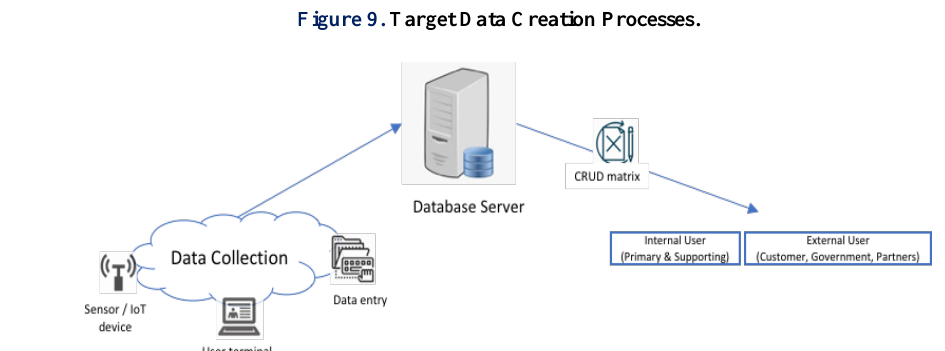
Figure 9. Target Data Creation Processes.